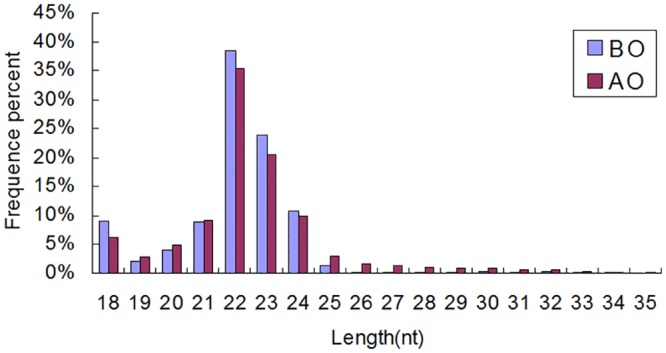
Length distribution of the clean reads in BO and AO.The X axis indicates sequence size from 18nt to 35nt. The Y axis indicates the percents of reads for every given size. The majority of sequences for both libraries were 21nt ~ 24nt. BO, before onset of the rapid gonad development; AO, after onset of the rapid gonad development.